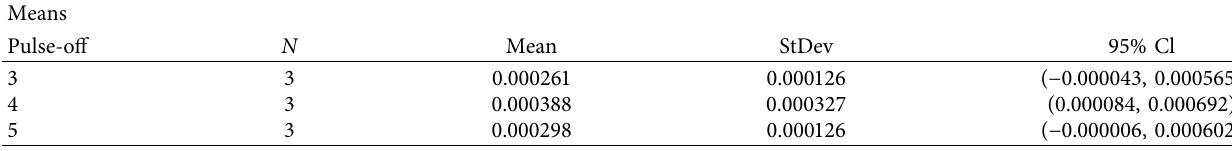
Table 13: Means and standard deviation at different pulse-off times for